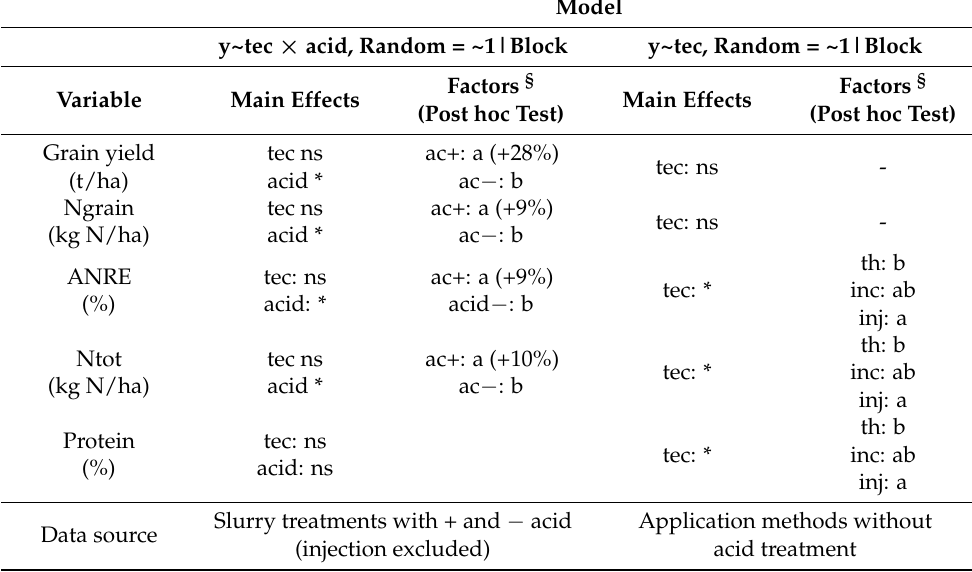
Table 4. Yield effects of cattle slurry spread with 3 different application methods with and without acidification (sulphuric acid) to summer barley. * significant main effect. alpha < 0.05, ns, nonsignifi- cant. Mixed effects models with HSD post hoc test ( p < 0.05), different letters indicate significance levels (values level “a” > values level “b”).